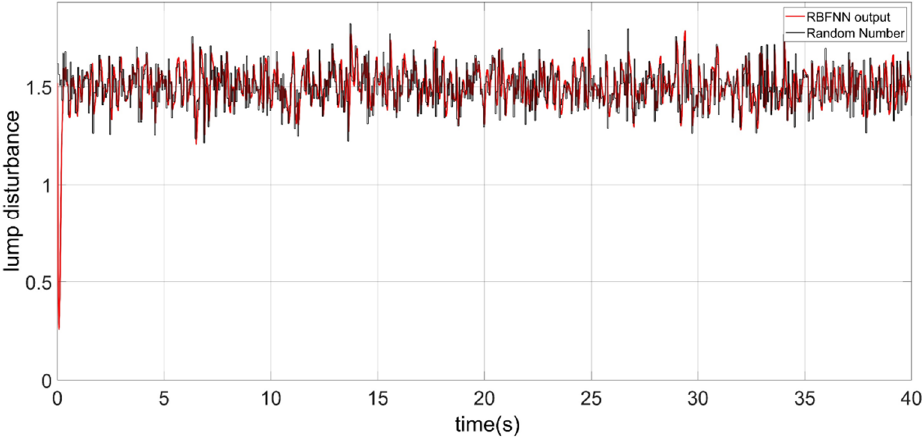
Figure 18. The output of yaw angular velocity RBFNN. The mean value of random disturbance is